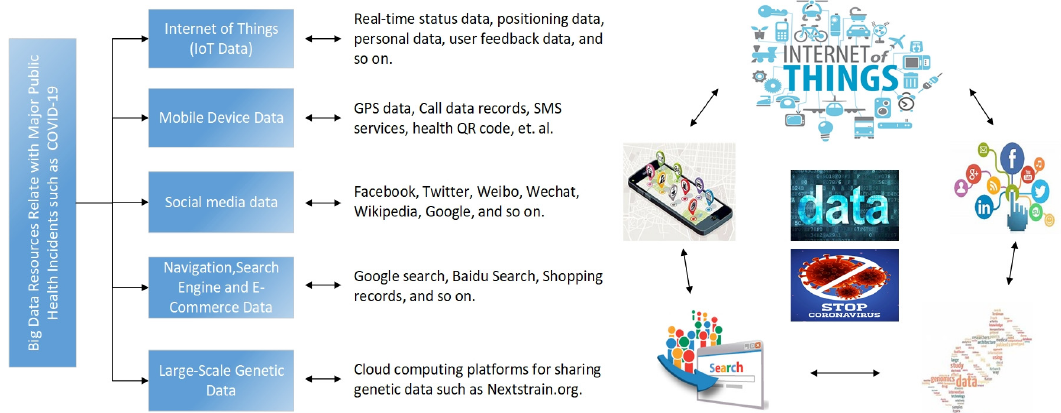
Figure 3. A taxonomy of big data resources associated with major public health incidents such as COVID-19.